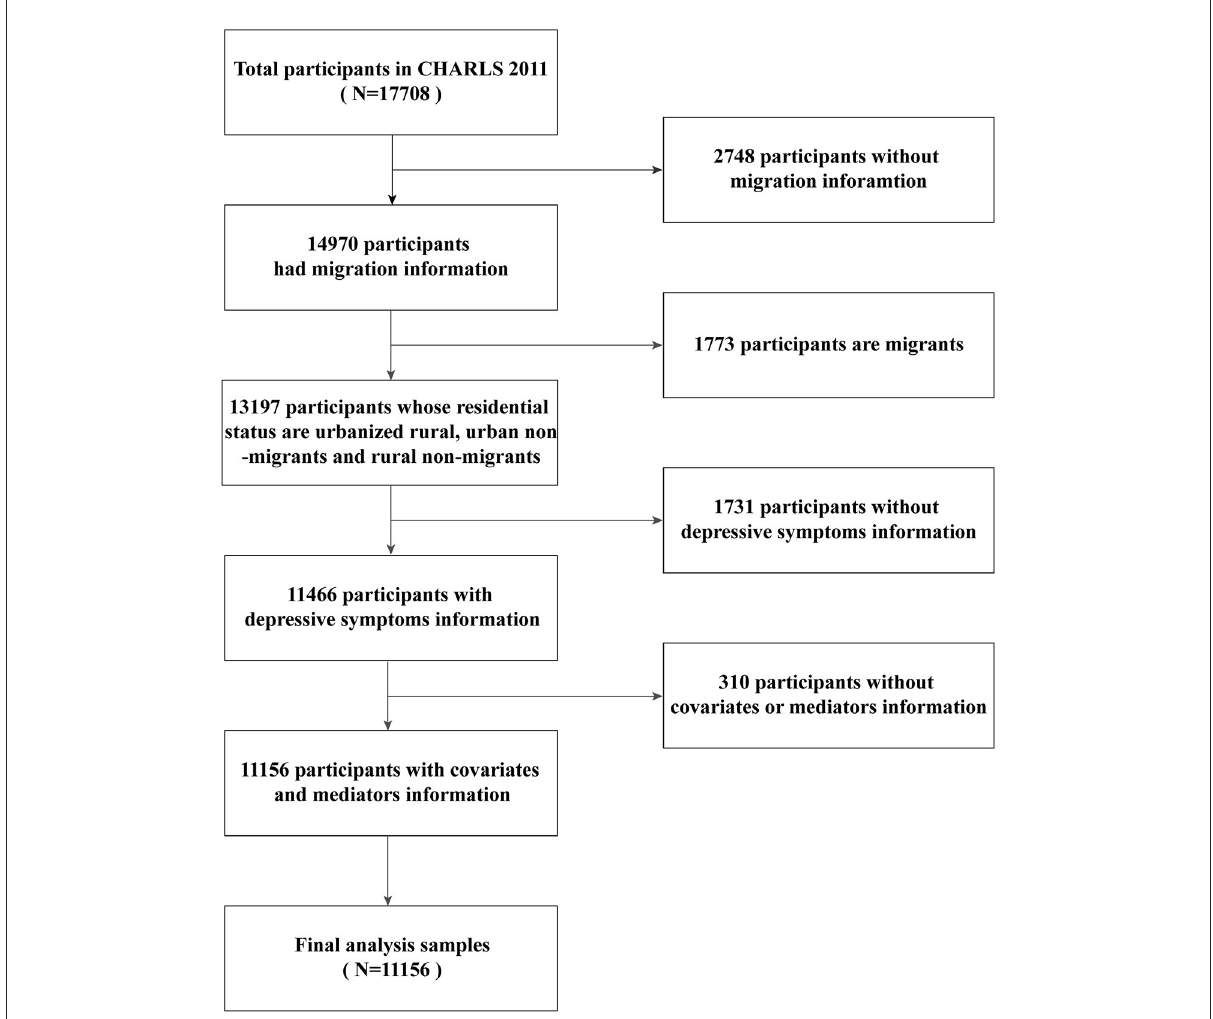
FIGURE1 Flowchart of sampling of this study.